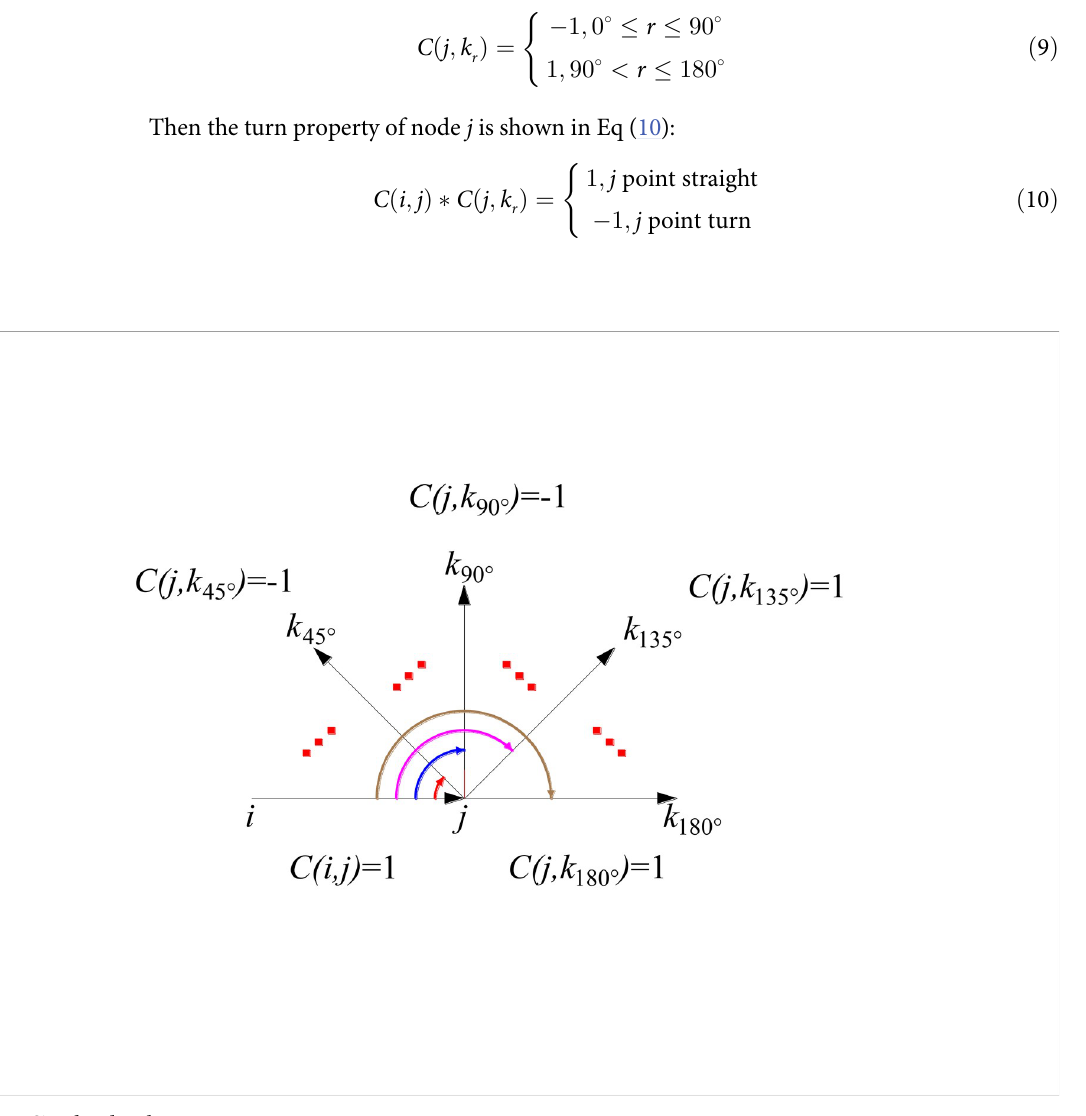
Fig 2. Simulated